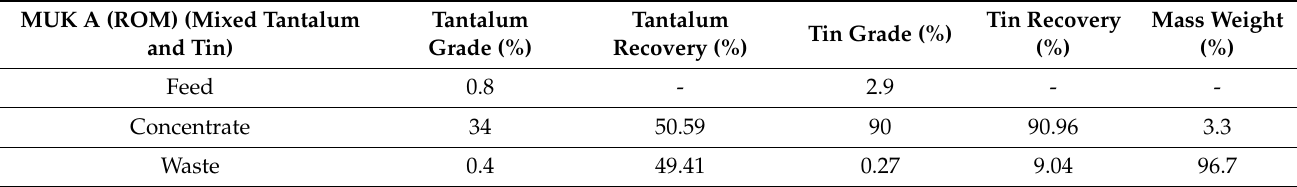
Table 5. MUK A mechanized processing